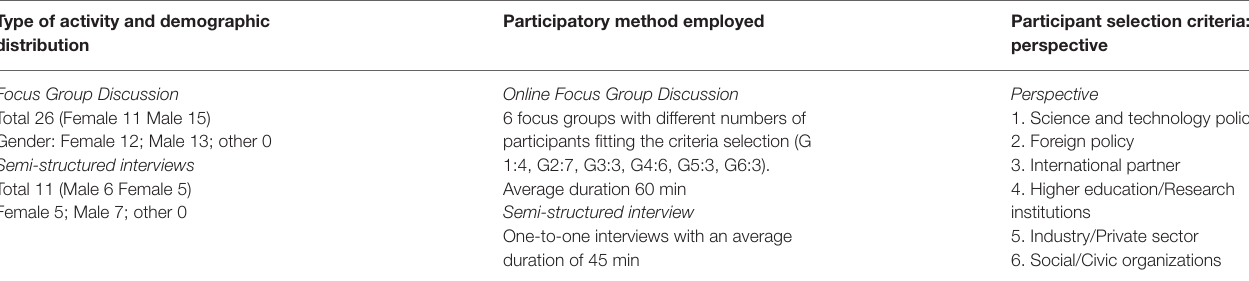
TABLE 4 | Participants from the stakeholders: method, demographic distribution and fulfillment of the selection criteria. Type of activity and demographic distribution